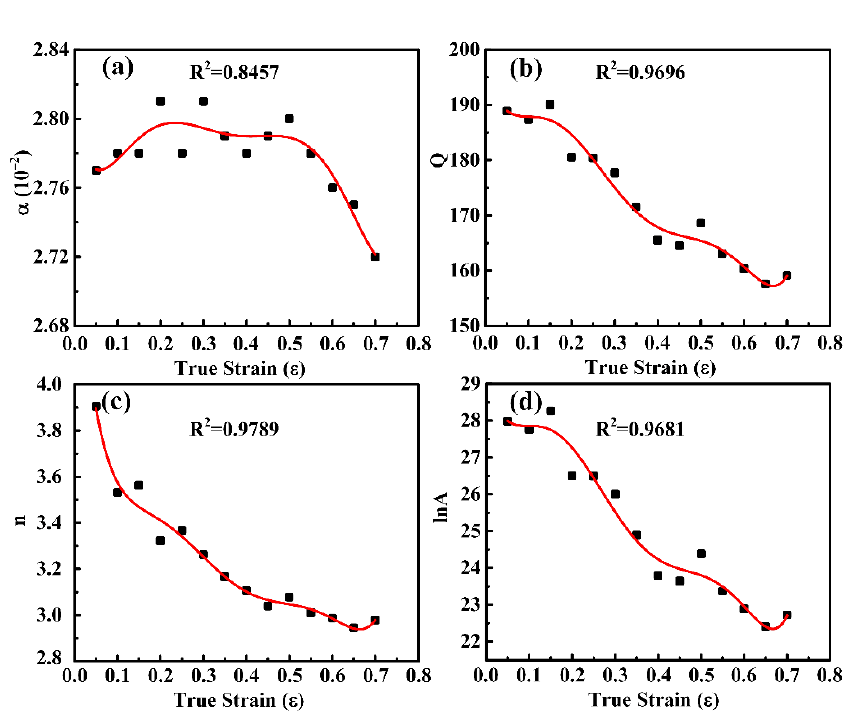
Figure 6. The polynomial fitting results of the material constants: ( a ) α − ε ; ( b ) Q − ε ; ( c ) n − ε and ( d ) ln A − ε .